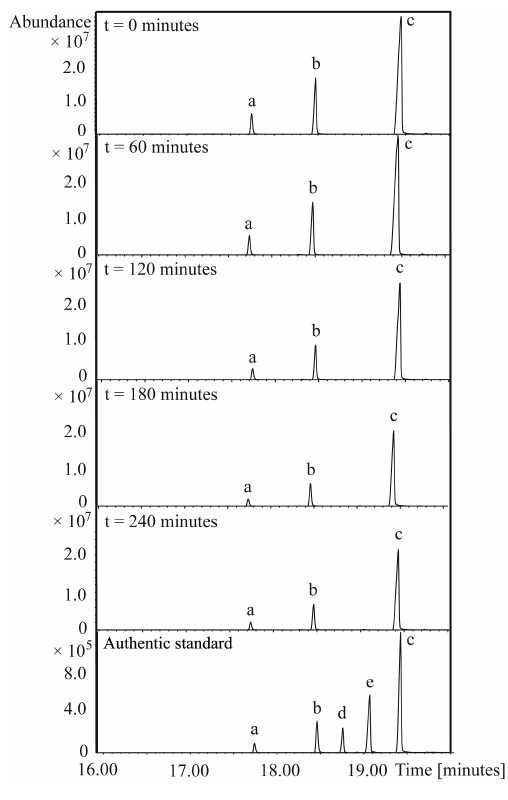
Figure 2. GC/MS chromatogram of oxidation of 2,3-butanedione (a, b, c) and the authentic standard compounds 2,3-butanedione (a, b, c) and methylglyoxal (d, e) .